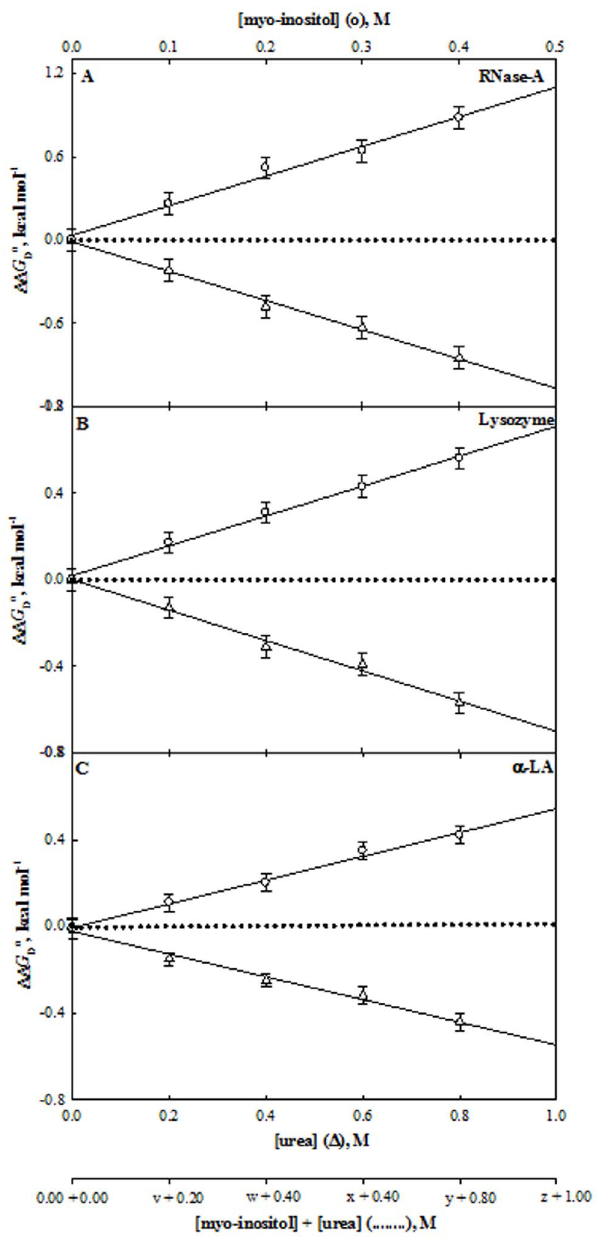
Figure 4. Effect of myo-inositol, urea and their mixtures on stability of proteins at pH 7.0 and 25 6 C. Plots of DD G Do versus [myo-inositol] ( # ) and [urea] ( D ). The dotted line represents the DD G Do values measured at the predicted ratios (see Table 2). The values of v, w, x, y and z of each protein are those predicted from results given in Table 2. For instance, value of y for myo-inositol is 0.40 M for RNase-A, lysozyme and a -LA.